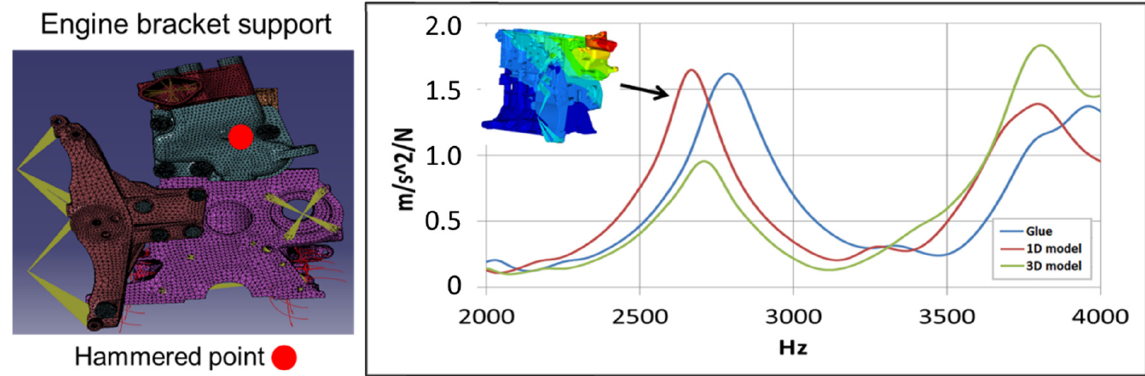
Figure 8. FRFs in the frequency range 2000–4000 Hz, for the four hammered positions with highlight of eigenmodes related to the highest resonance amplitudes.